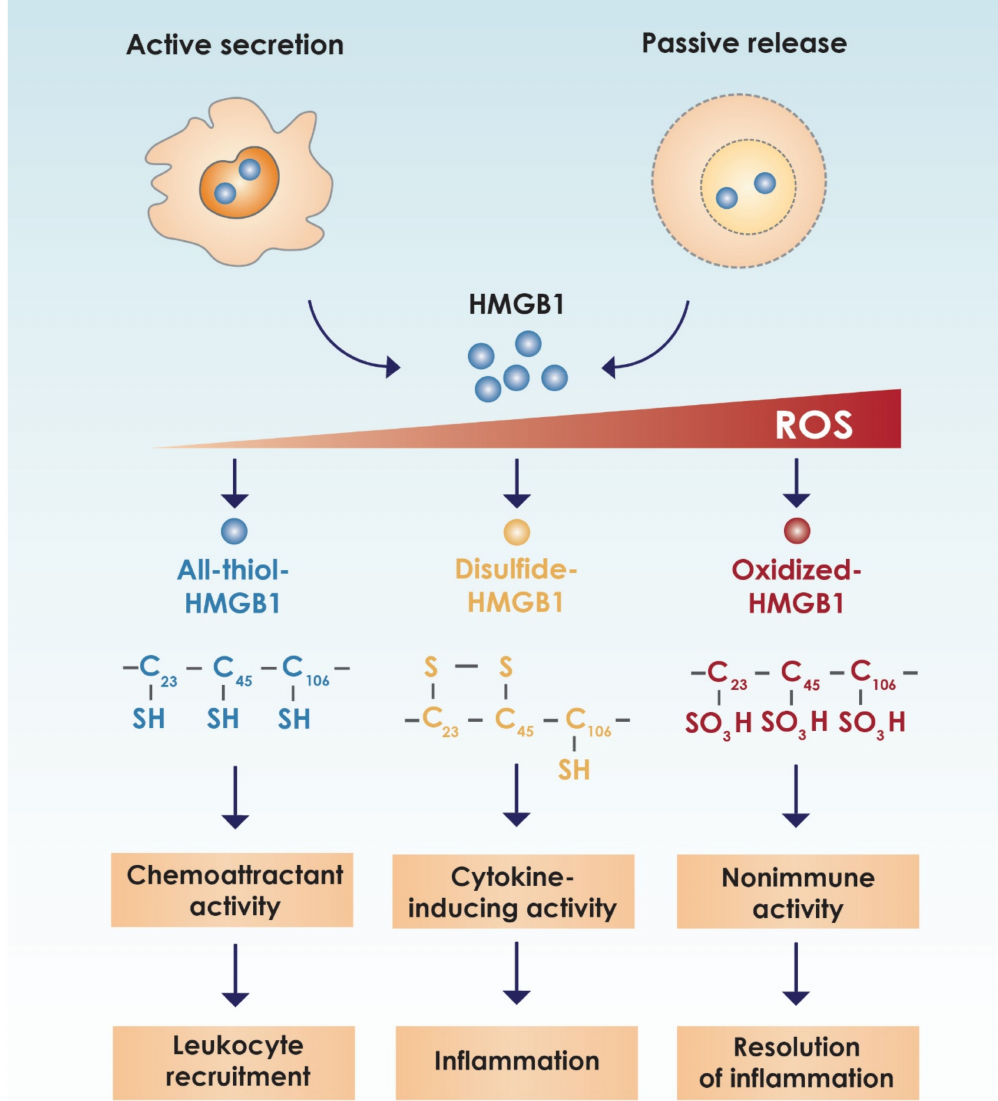
Figure 2. The redox state of HMGB1 determines the activity of the protein. Chemokine production and leukocyte recruitment are mediated by all-thiol-HMGB1. In turn, disulfide-HMGB1 facilitates the release of proinflammatory cytokines. During resolution of inflammation, reactive oxygen species inactivate HMGB1 by inducing the terminal oxidation of the protein [16]. Reprinted by